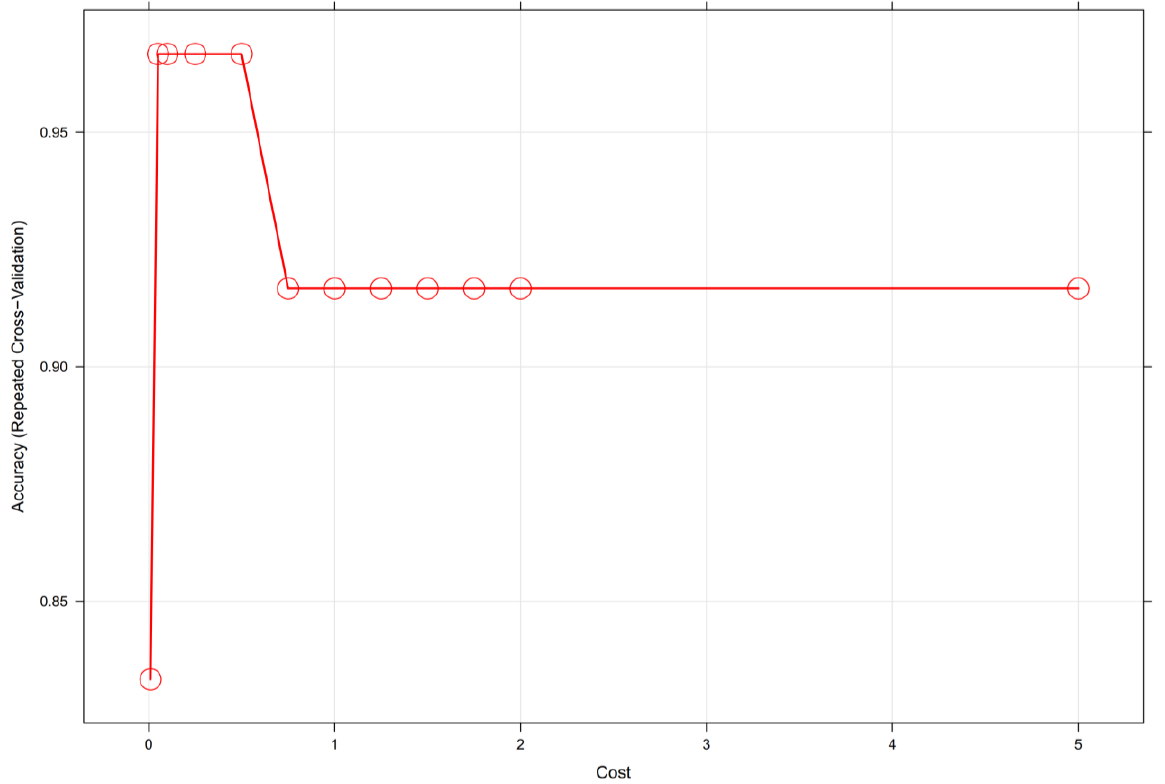
Figure 3. SVM Linear